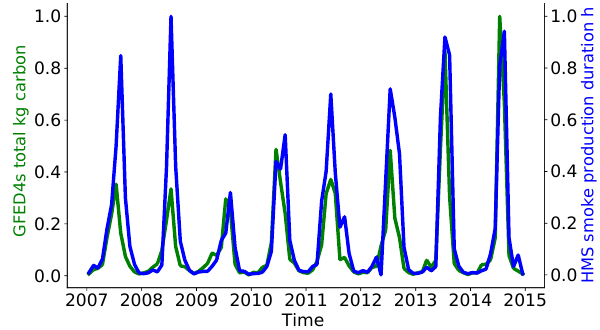
Figure 4. Time series of monthly domain (20–80 ◦ N, 50–170 ◦ W) summed kilograms of carbon (left axis) and HMS hours (right axis). Monthly totals have been divided by the maximum monthly value observed between 2007 and 2014. The Pearson correlation coeffi- cient for the presented monthly time series is